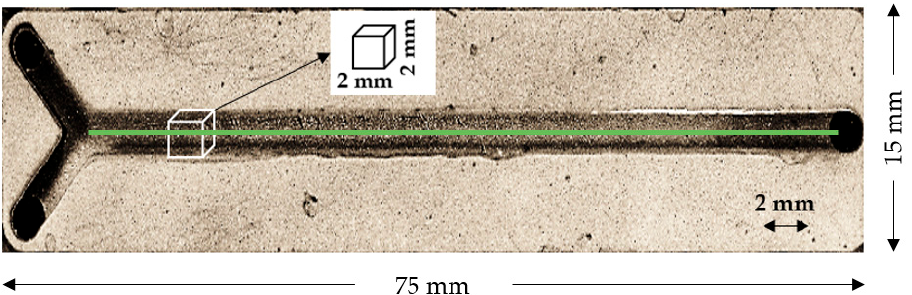
Figure 4. Top-down view of aluminum Y-junction mini-channel with two inlets and one outlet; square cross-section of 2 mm × 2 mm, 75-mm channel length. The line in green is used to calculate the intensity at a wavelength.